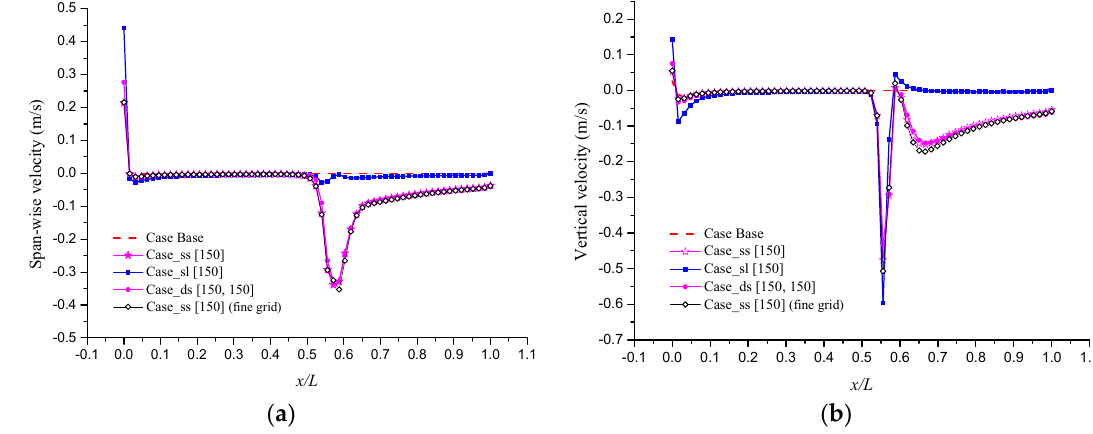
Figure 4. Velocity along the left pedestrian side ( a ) span-wise velocity under three basic catcher arrangements; ( b ) vertical velocity under three basic catcher arrangements.